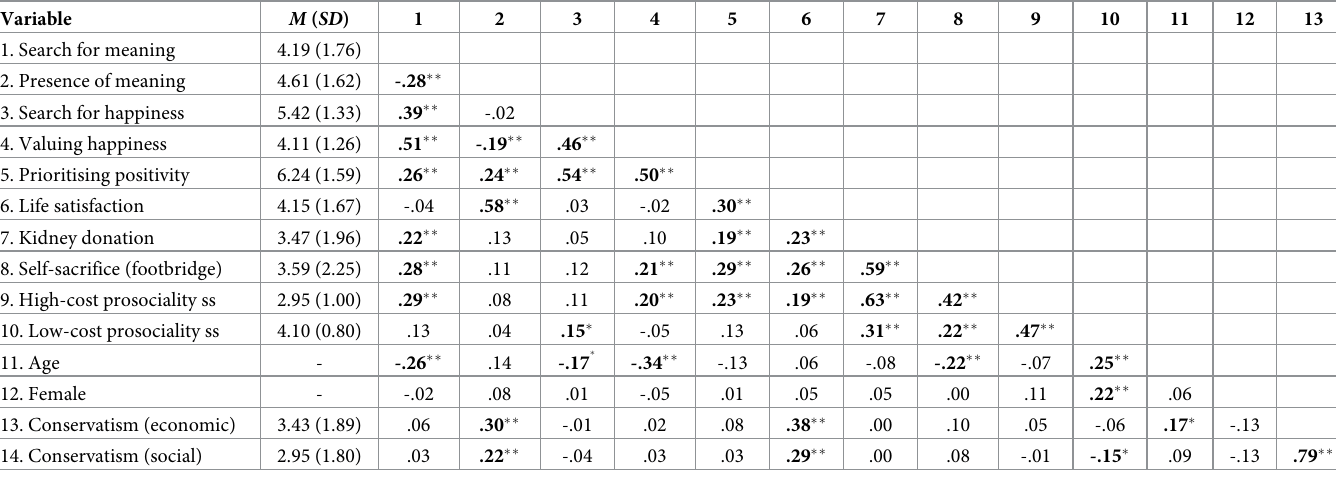
Table 5. Correlations matrix and descriptives in Study 3. Variable